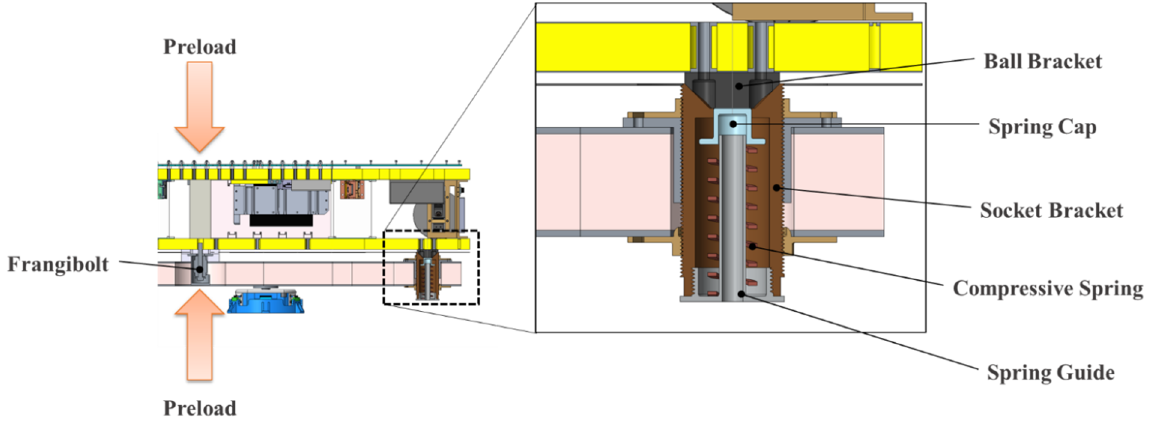
Figure 7. Zoomed cross-sectional view of the in-orbit separation mechanism of the VFOD.